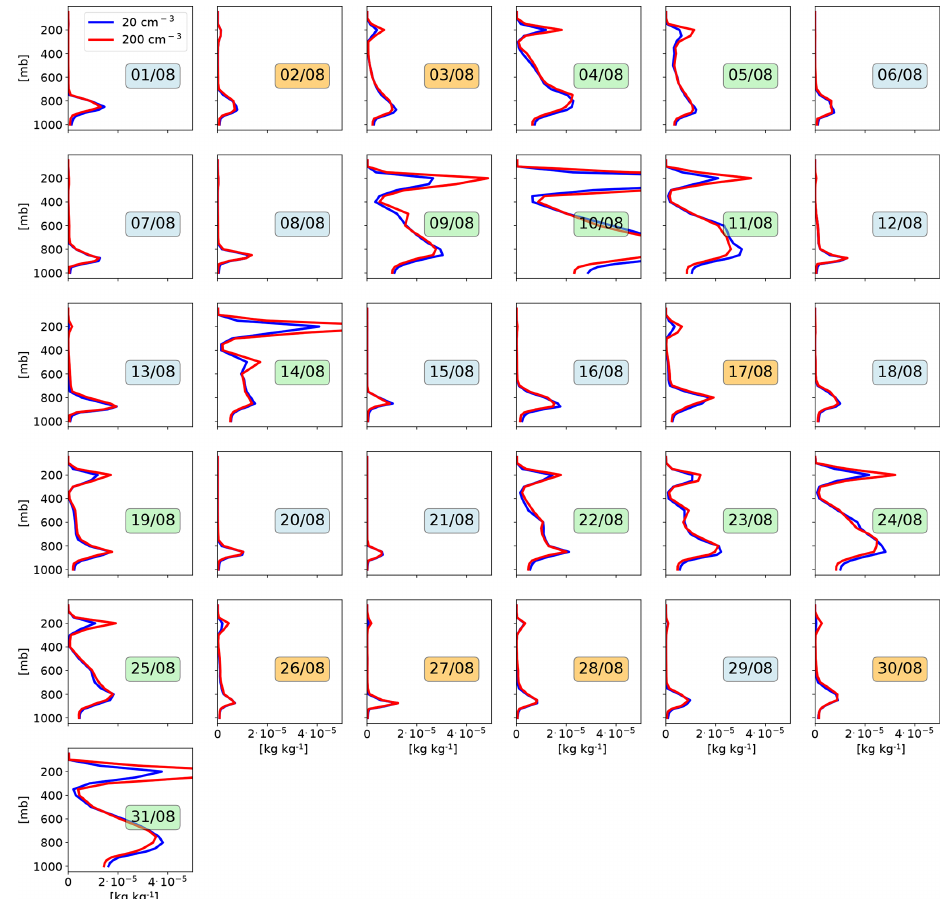
Figure 3. Mean (time and space) vertical profiles of the total water (liquid and ice) mixing ratio in each simulation (each last for 24h) for the NARVAL 2 month (August 2016). Blue: clean conditions (20cm − 3 ), red: polluted conditions (200cm − 3 ). The simulated days are separated into three different cloud regimes: shallow clouds (blue date box), two-layer clouds (shallow cloud layer and a cirrus cloud layer – orange date box), and deep clouds (green date